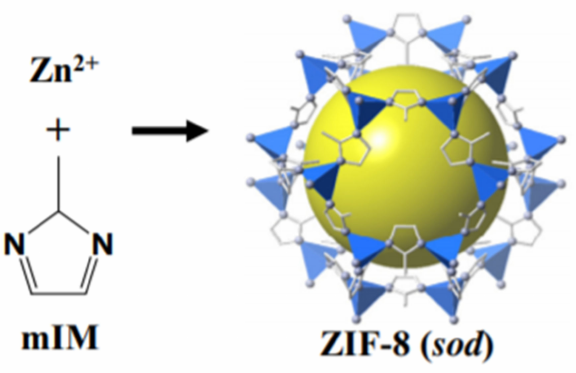
Figure 13. ZIF-8 crystal structure [187]. Reprinted/adapted with permission from Ref. [187]. Copy- right 2022,